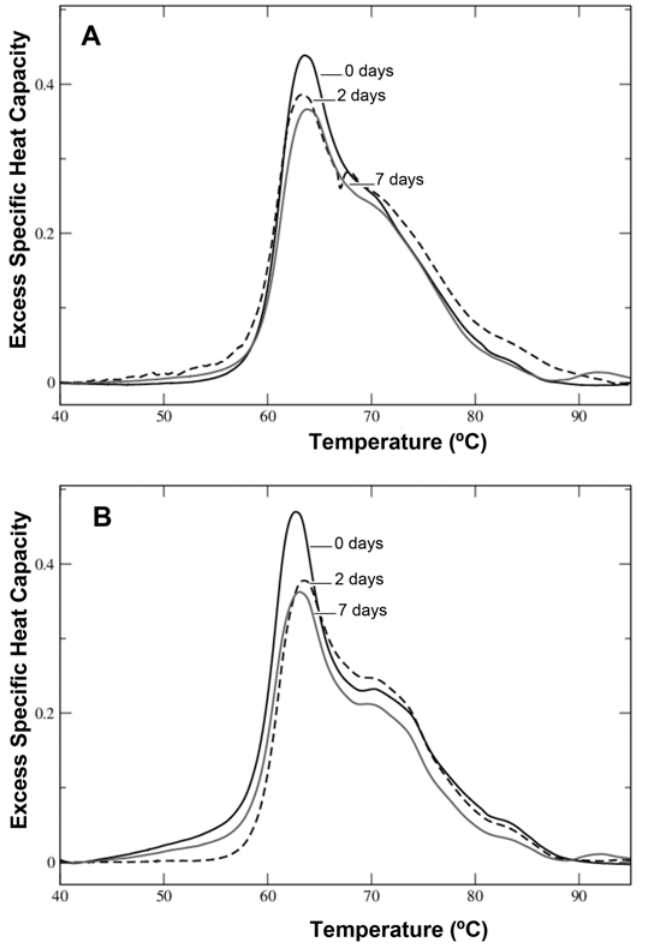
Fig 1. DSC thermograms of blood serum samples stored at 4°C for different periods of time. (A) Thermograms of healthy serum samples analyzed immediately (0 days), and after 2, or 7 days. (B) MGUS- κ serum samples (experimental group based on the κ light chain that is associated with different monoclonal immunoglobulin heavy chains) analyzed after 0, 2, and 7 days.